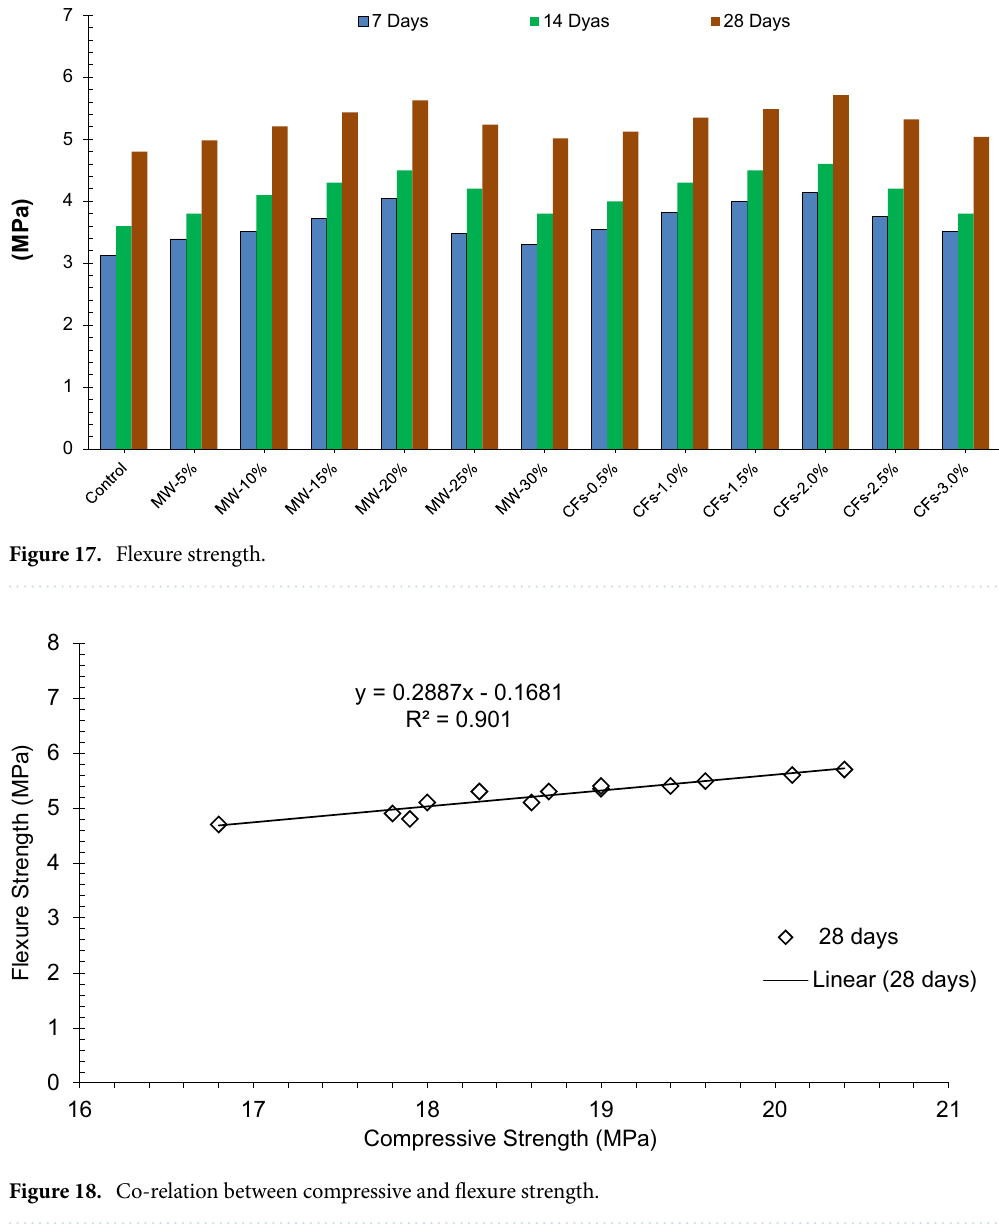
Figure 18. Co-relation between compressive and flexure